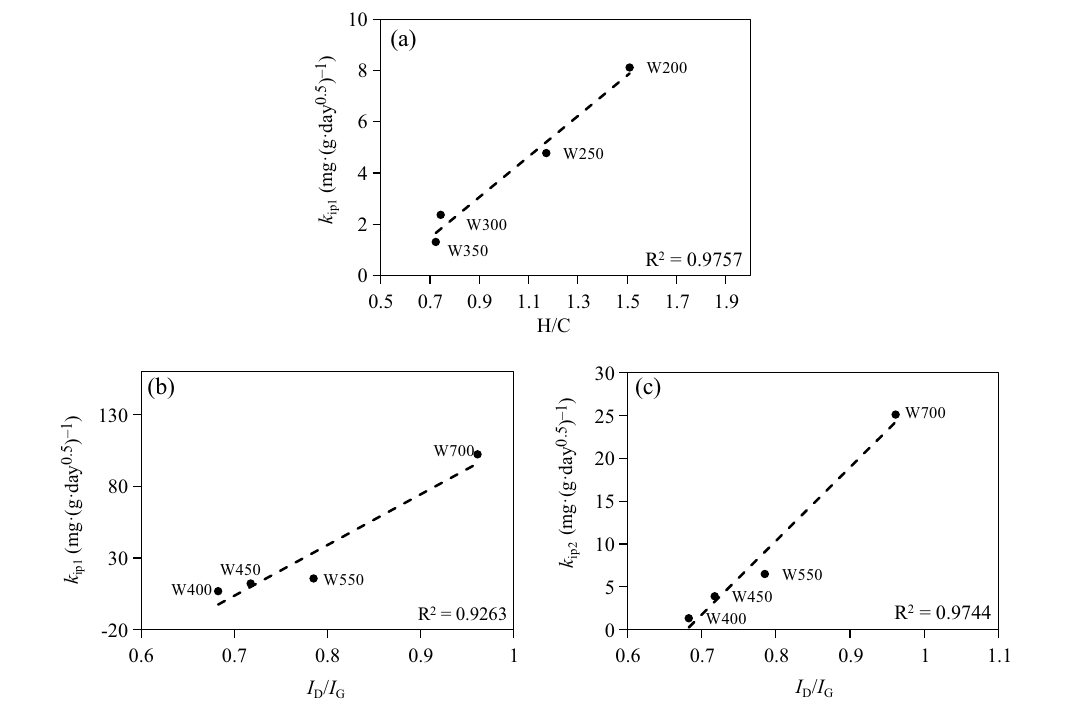
Fig. 4 Matrix diffusion rate ( k ip1 ) of 1,3,5-trinitrobenzene as a function of H/C ratios of W200, W250, W300 and W350 ( a ); outer diffusion rate ( k ip1 ) ( b ) and slow intraparticle diffusion rate ( k ip2 ) ( c ) of 1,3,5-trinitrobenzene as a function of I D / I G values of W400, W450, W550 and